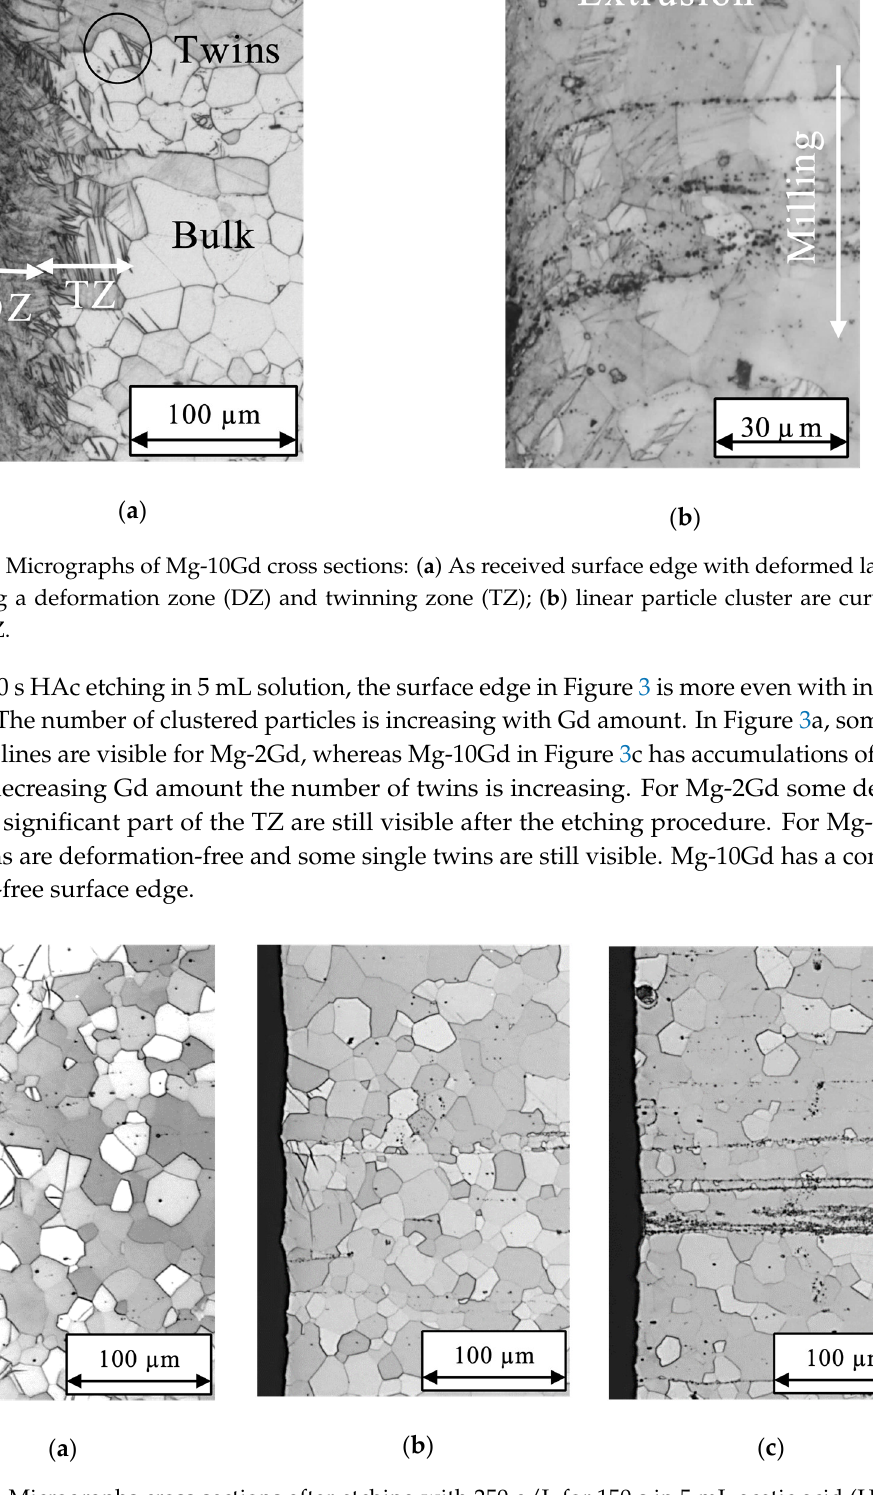
Figure 3. Micrographs cross sections after etching with 250 g/L for 150 s in 5 mL acetic acid (HAc) solution: ( a ) uneven surface edge of Mg-2Gd with partly non-deformed grains and grains including twins, some single black particles are visible; ( b ) mainly deformation free surface edge of Mg-5Gd with some single twins and partly visible particle lines; ( c ) deformation free surface edge of Mg-10Gd with linear particle